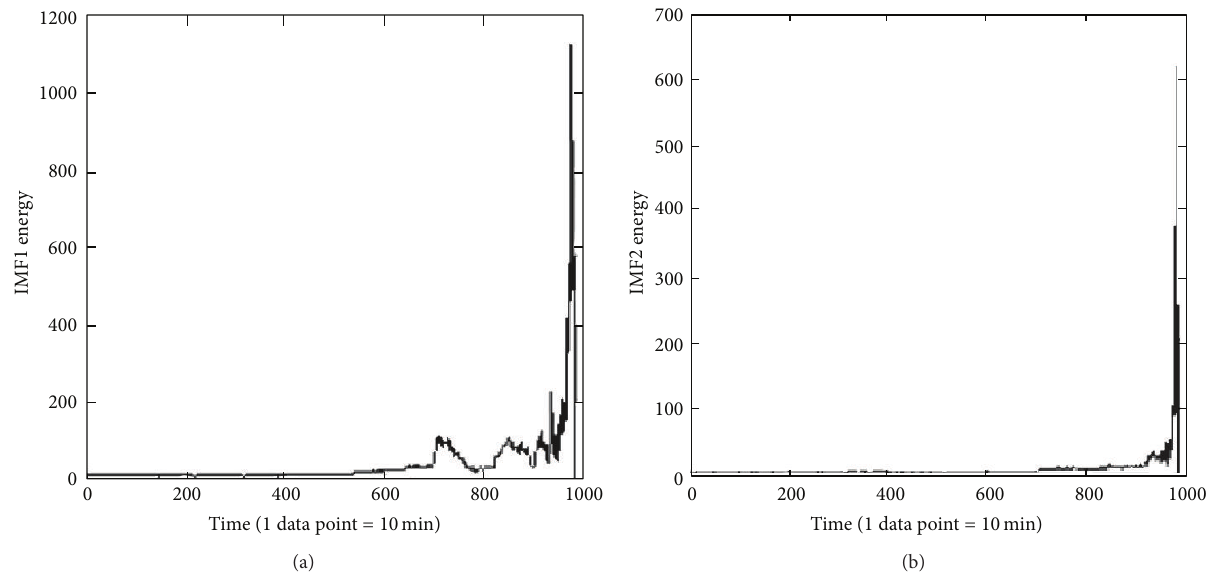
Figure 6: (a) IMF1 energy of bearing vibration data; (b) IMF2 energy of bearing vibration